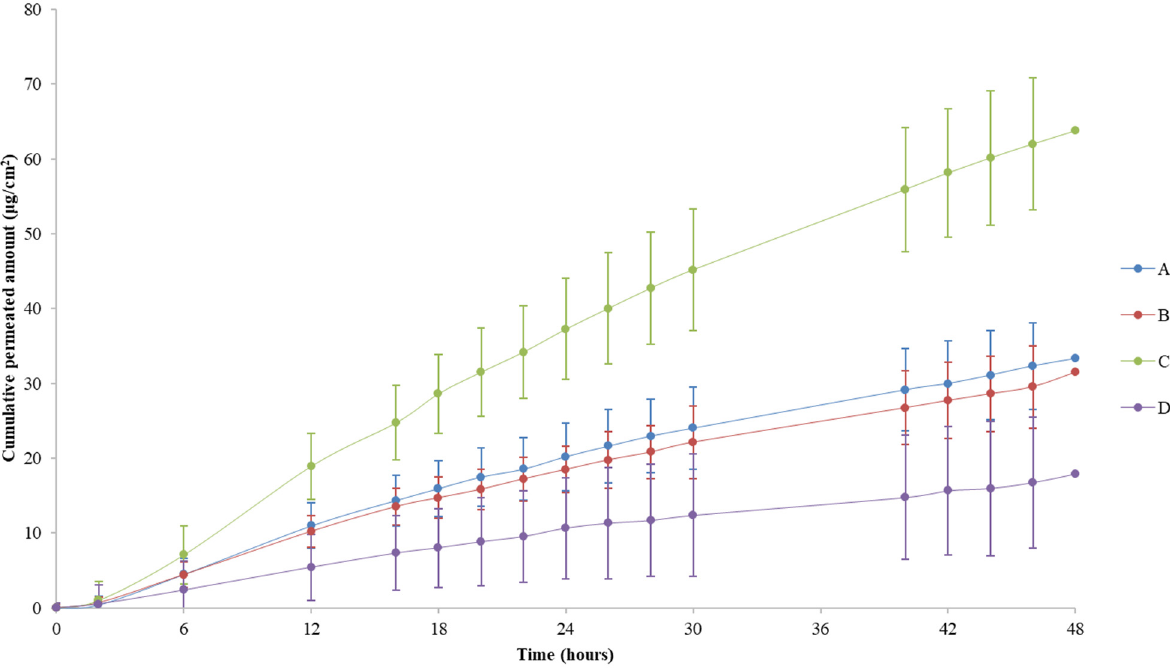
Figure 4. Cumulative permeated amount ( µ g/cm 2 ) per hour obtained throughout the 48 h assay (lines represent the mean with SD, n = 12) (A—clotrimazole 10 mg/g cream; B—Canesten Antifungal Cream 10 mg/g cream; C—clotrimazole 20 mg/g cream; D—clotrimazole 5 mg/g cream).